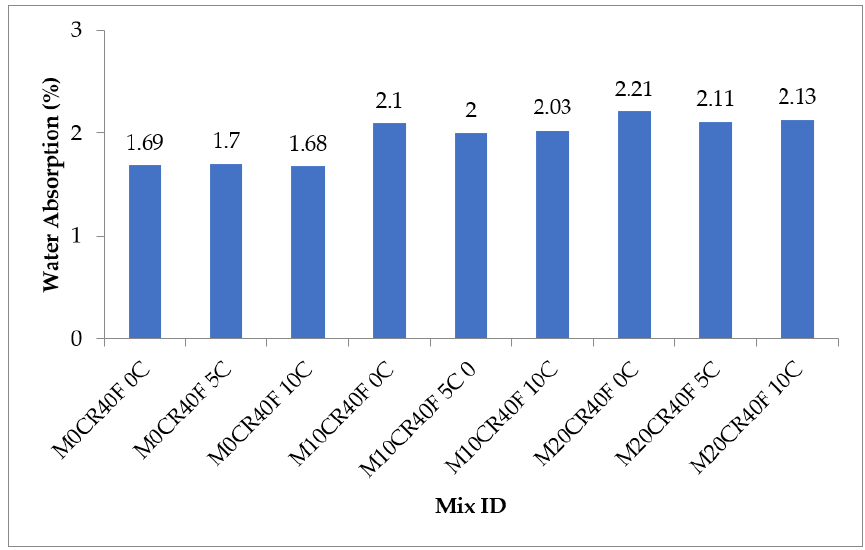
Figure 12. Water absorption of SCC mixes containing fly ash, CR, and CCW.